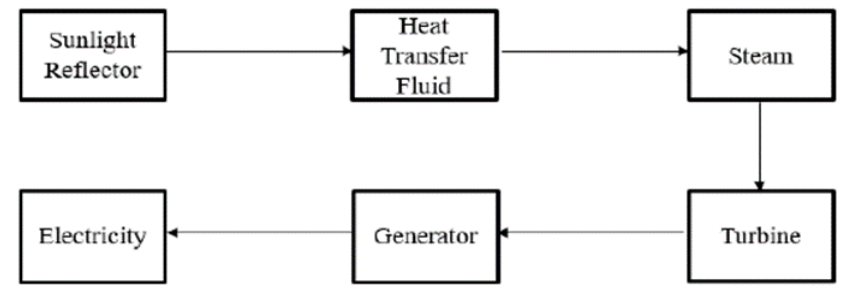
Figure 3: Solar thermal electricity